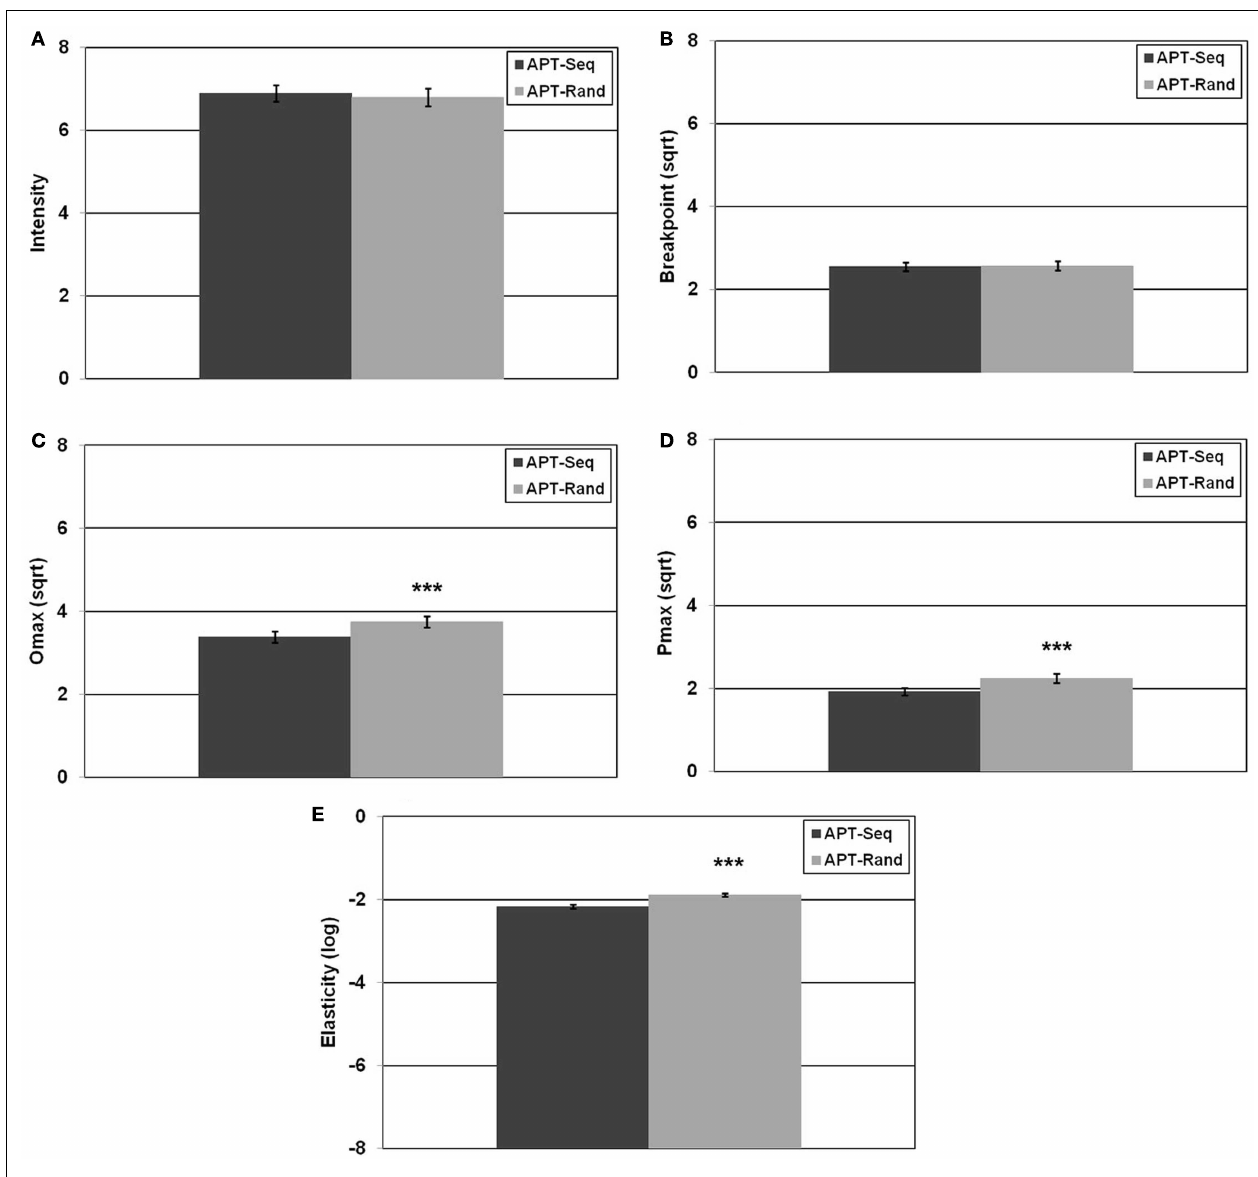
FIGURE 2 | Indices of alcohol demand across sequential (APT-Seq; dark gray bars) and randomized (APT-Rand; light gray bars) versions. (A) Depicts intensity of demand. (B) Depicts square-root transformed breakpoint.